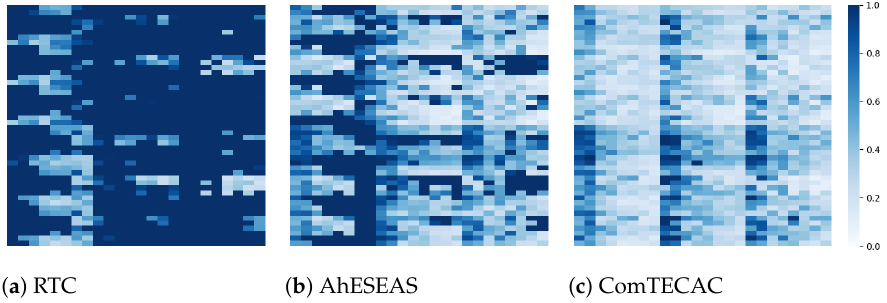
Figure 6. Older clusters’ makespan (light is better).